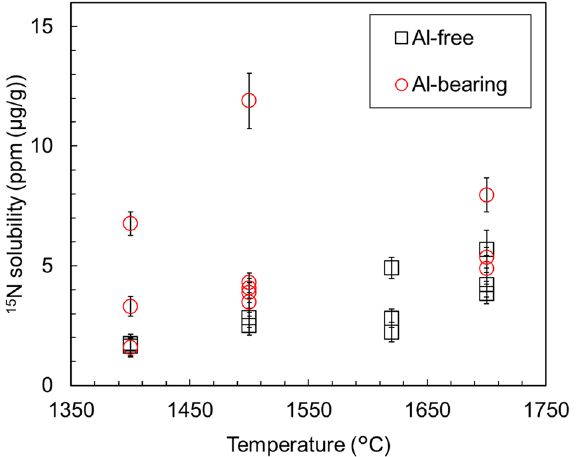
Figure 3. Plots showing the nitrogen solubility in bridgmanite at different temperatures. All data points represent the single measurement points of the sample.